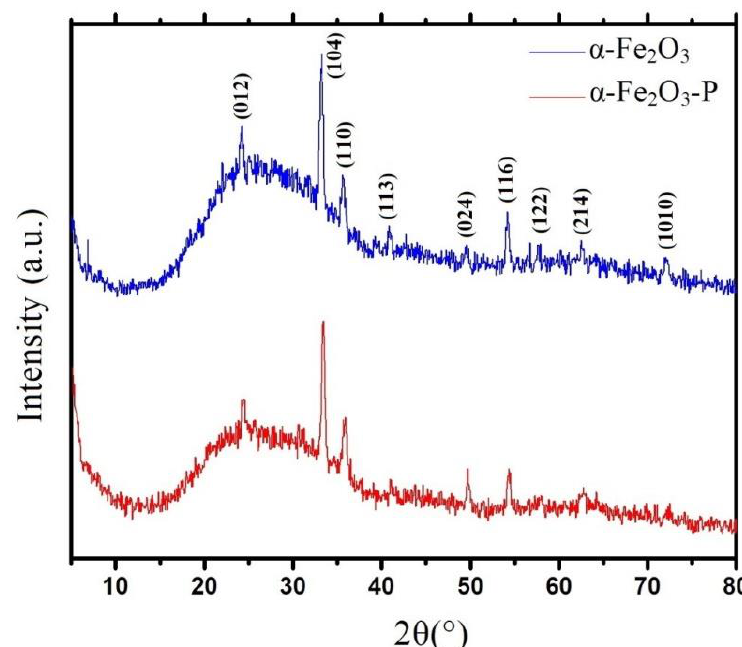
Figure 2. X-ray Powder Diffraction Pattern of α-Fe 2 O 3 Thin Films prior to the Plasma application and α-Fe 2 O 3 -P following the Plasma application 3-2- FESEM Microscope